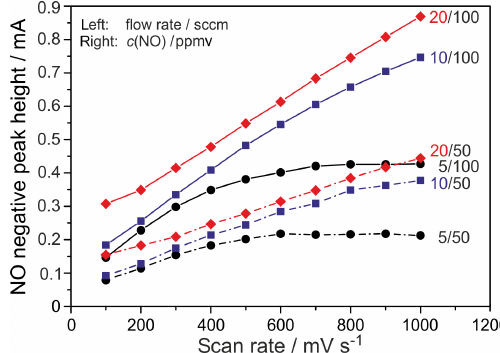
Figure 5. Dependence of the NO peak height on the scan rate at different flow rates and NO concentrations. T = 750 ◦ C; c (O 2 ) =